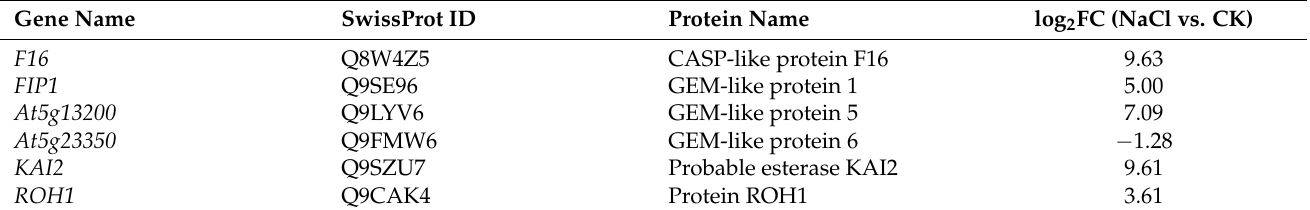
Table 5. Six DEGs directly associated with cell morphogenesis for seed germination at 300 mmol/L NaCl vs. CK.